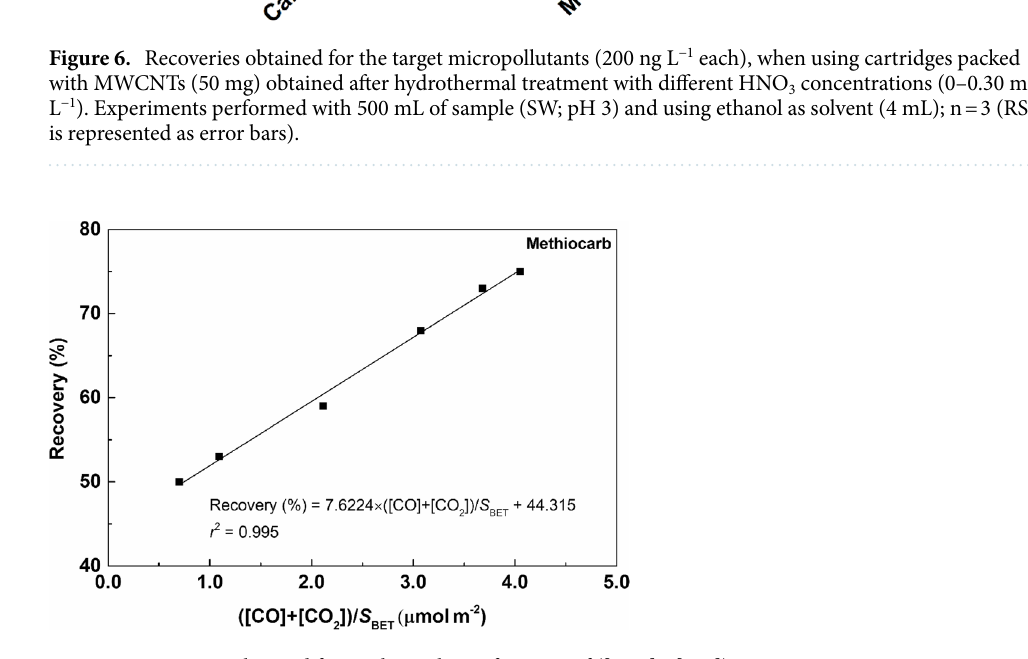
Figure 7. Recovery obtained for methiocarb as a function of ([CO 2 ] + [CO])/ S BET